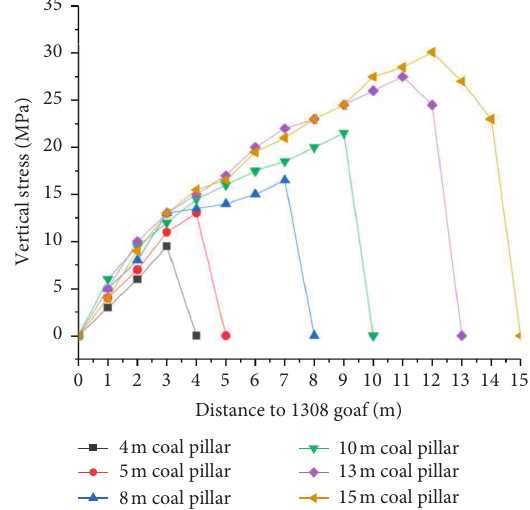
Figure 15: Vertical stress curves of coal pillars in different width